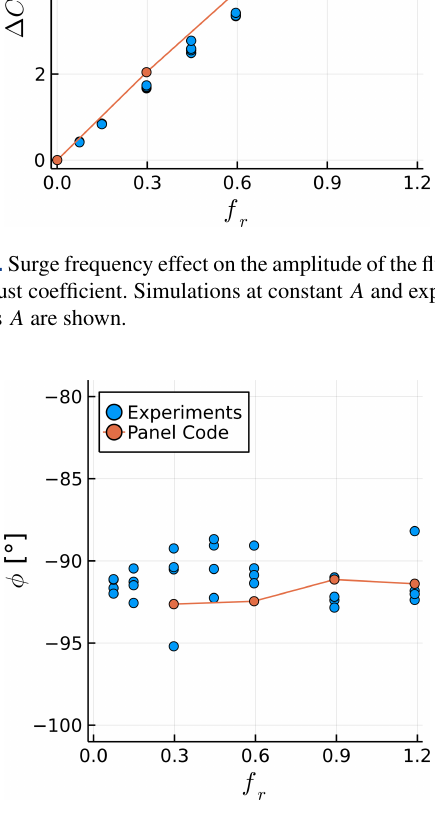
Figure 5. Surge frequency effect on the phase between the rotor position and its thrust. Simulations at constant A and experiments at various A are shown.